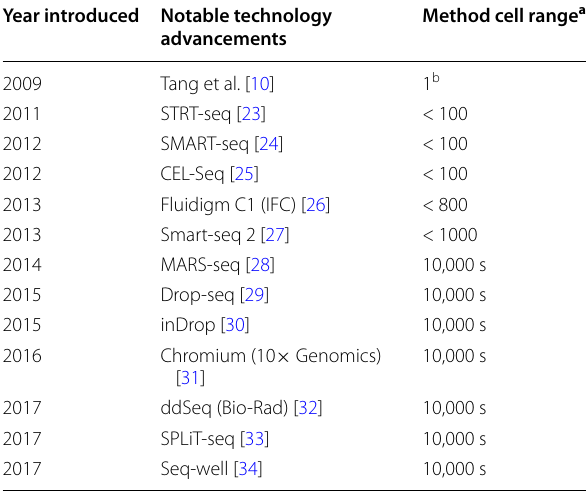
This is a non-comprehensive list of peer-reviewed studies that advanced single- cell isolation and preparation techniques a The “range” lists the largest relative population that can or has been studied using this technique b This method involves mechanical separation and isolation of individual blastomeres into single